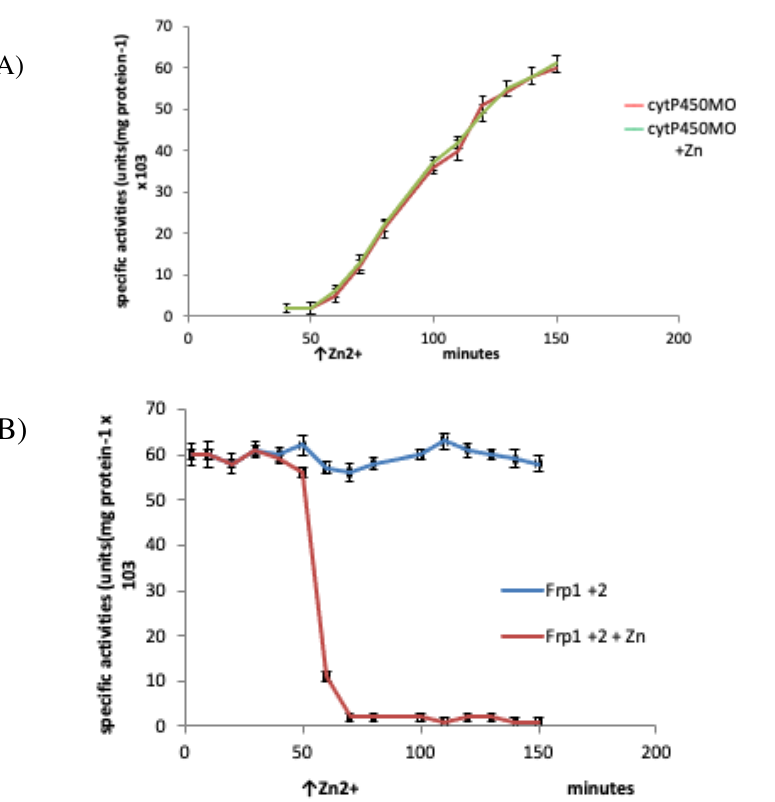
Figure 16. Changes in the activity of ( A ) camphor 5-monooxygenase (cytP450MO), and ( B ) the combined Frp1 + Frp2 activity in P. putida ATCC 17453 in the presence and absence of 30 µ M Zn 2+ added during the diauxic interlude that occurs between the swop from late log growth on succinate to early log growth on ( rac )-camphor.